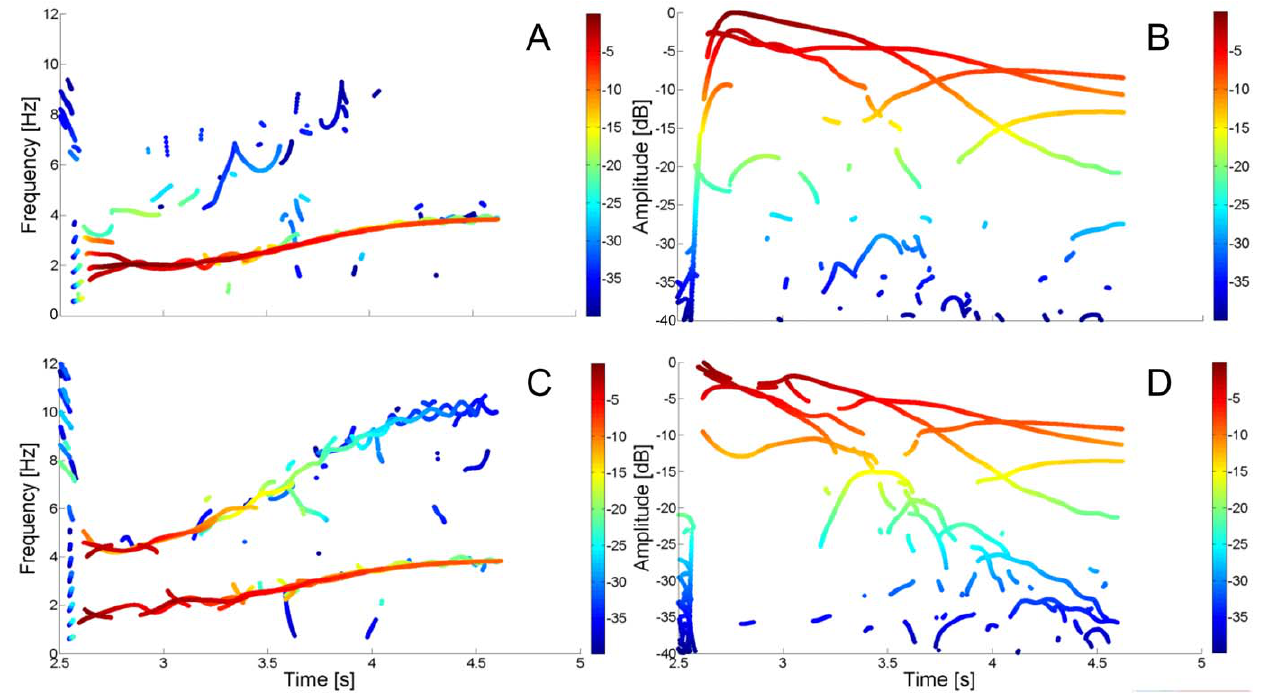
Figure 4. Orthogonal projection of the reassigned spectrogram for each separate joint. Orthogonal projection of the reassigned spectrogram for the variables L h 1 (A,B) and L h 2 (C,D) calculated with the maximum noise level (SNR=10 dB). Due to the different orientation of the eigenvector matrix P , the second frequency of L h 1 (A,B) has a lower power compared to that calculated for L h 2 (C,D); hence, the oscillation is still present but it is just above the noise level. The estimation of instantaneous frequency f i and instantaneous amplitude A i are however very clear when analyzing the spectrogram of L h 2 (C,D).